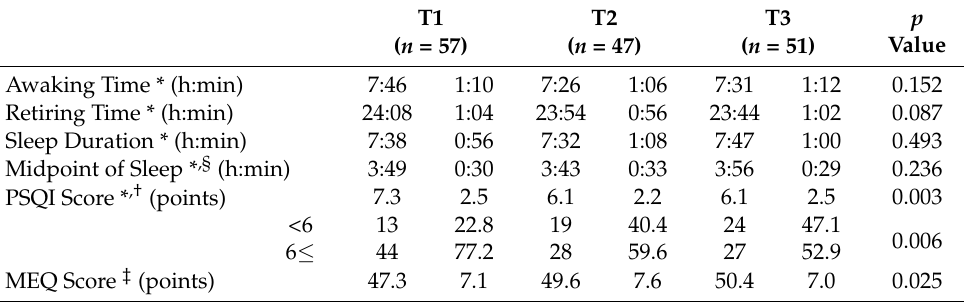
Table 3. Association between the Food Guide score and sleep